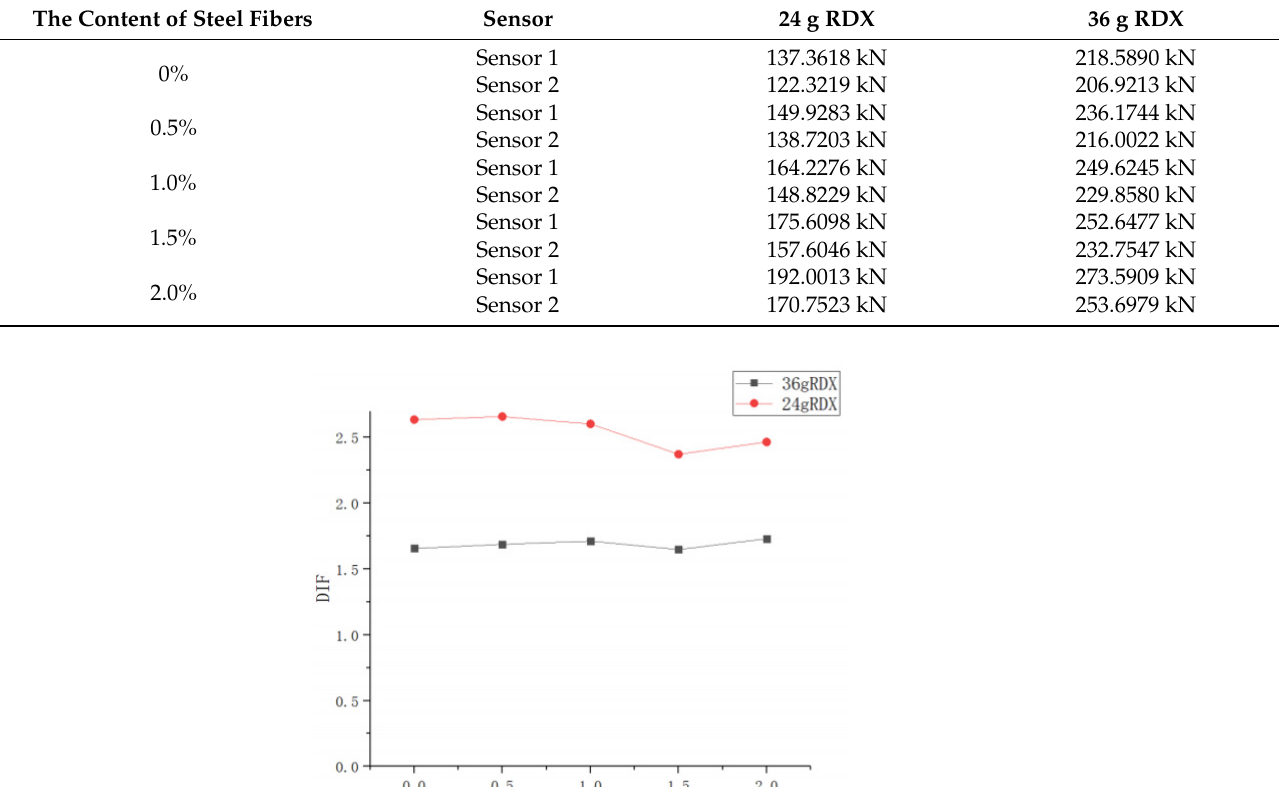
Table 3. Experimental results of plane explosion wave of spindle specimens with different steel fiber content.